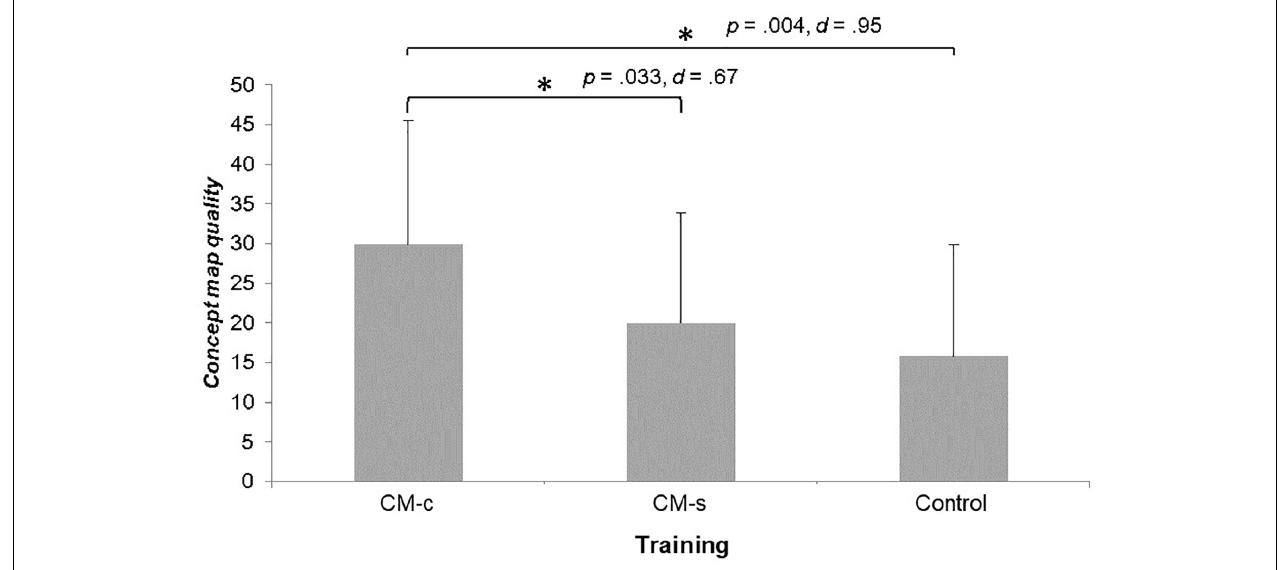
FIGURE 3 | Concept map quality. CM-c, concept map construction; CM-s, concept map